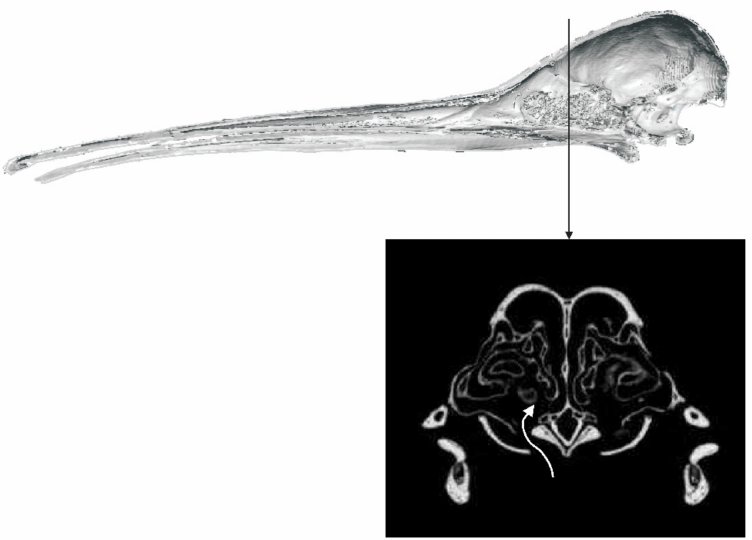
Figure 4. Apteryx , CT scan slice at the level of internal nares and turbinate system. The arrow indicates the route through the nares to the olfactory